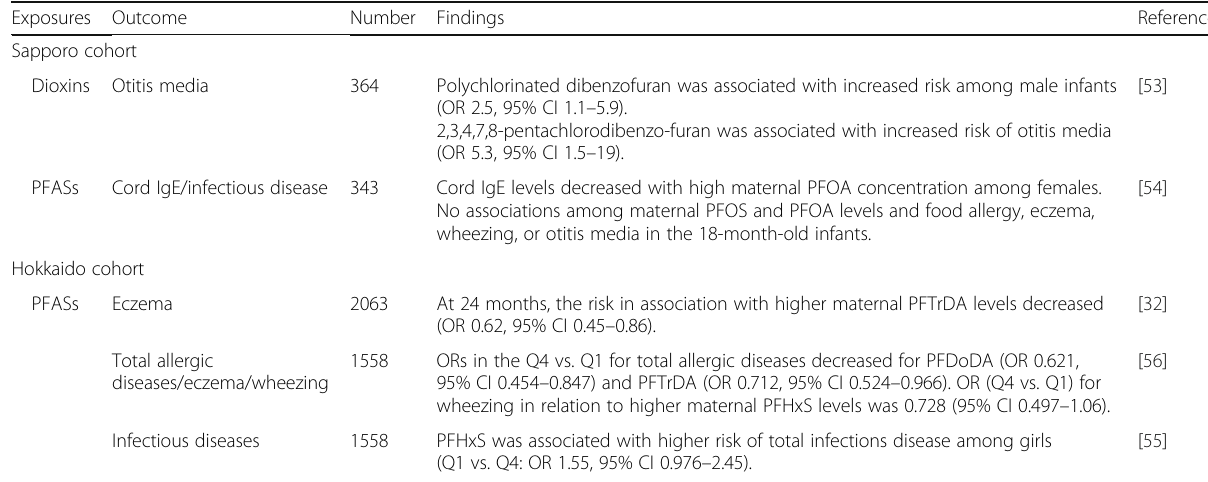
Table 10 Findings from the Sapporo and Hokkaido cohorts on the relationships between exposures and allergies and infectious diseases Exposures Outcome